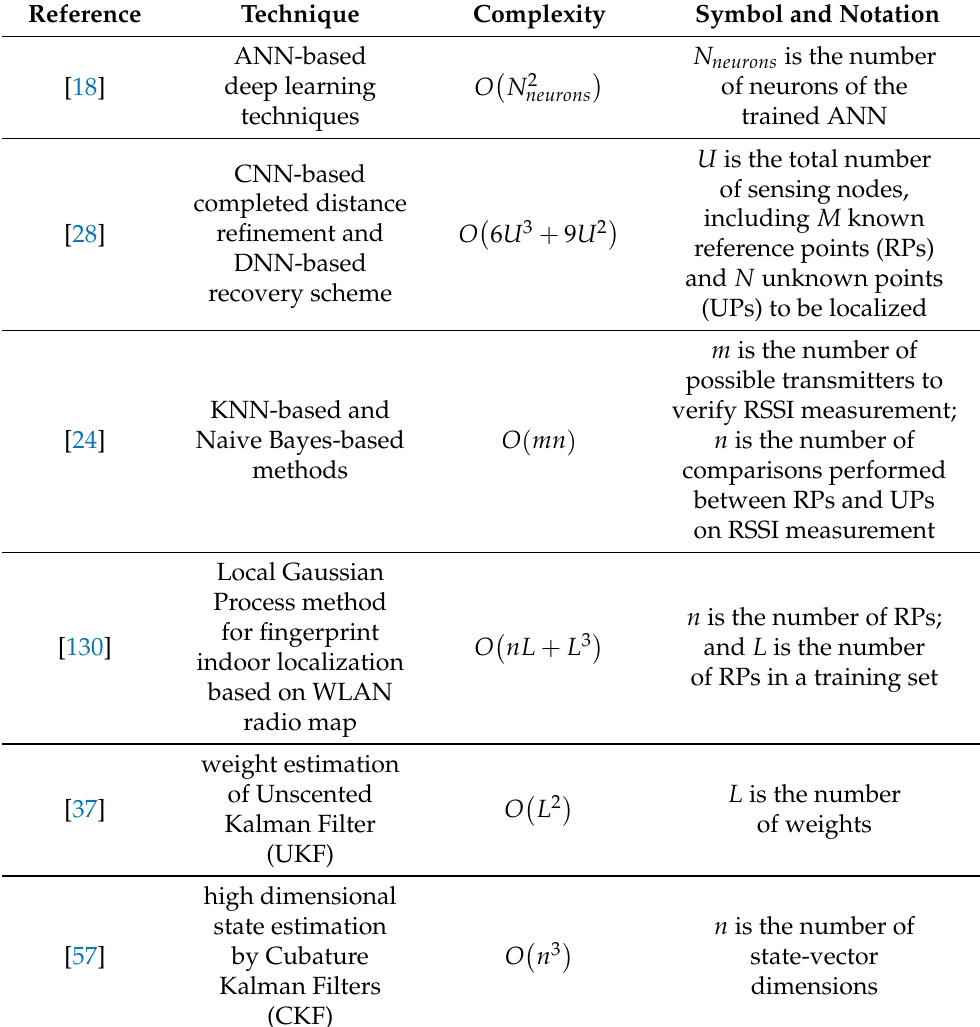
Table 4. Computational comparison of existing localization